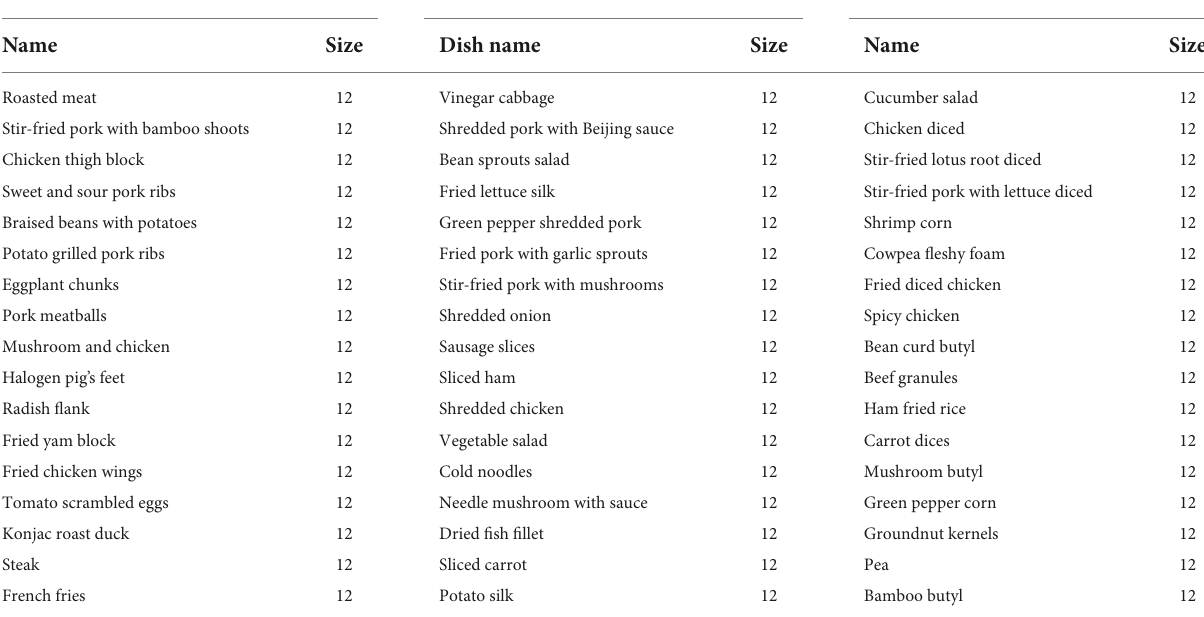
TABLE 2 Fifty-one common foods to